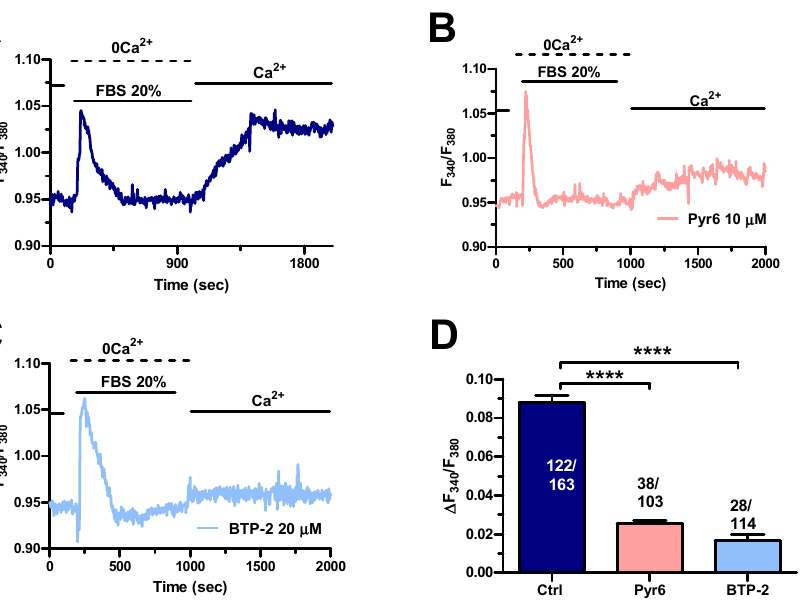
findings show that long-term exposure to PEVs leads to an increase in InsP 3 -induced ER Ca 2+ mobilization and SOCE that could potentiate the pro-migratory Ca 2+ response to se- rum stimulation.